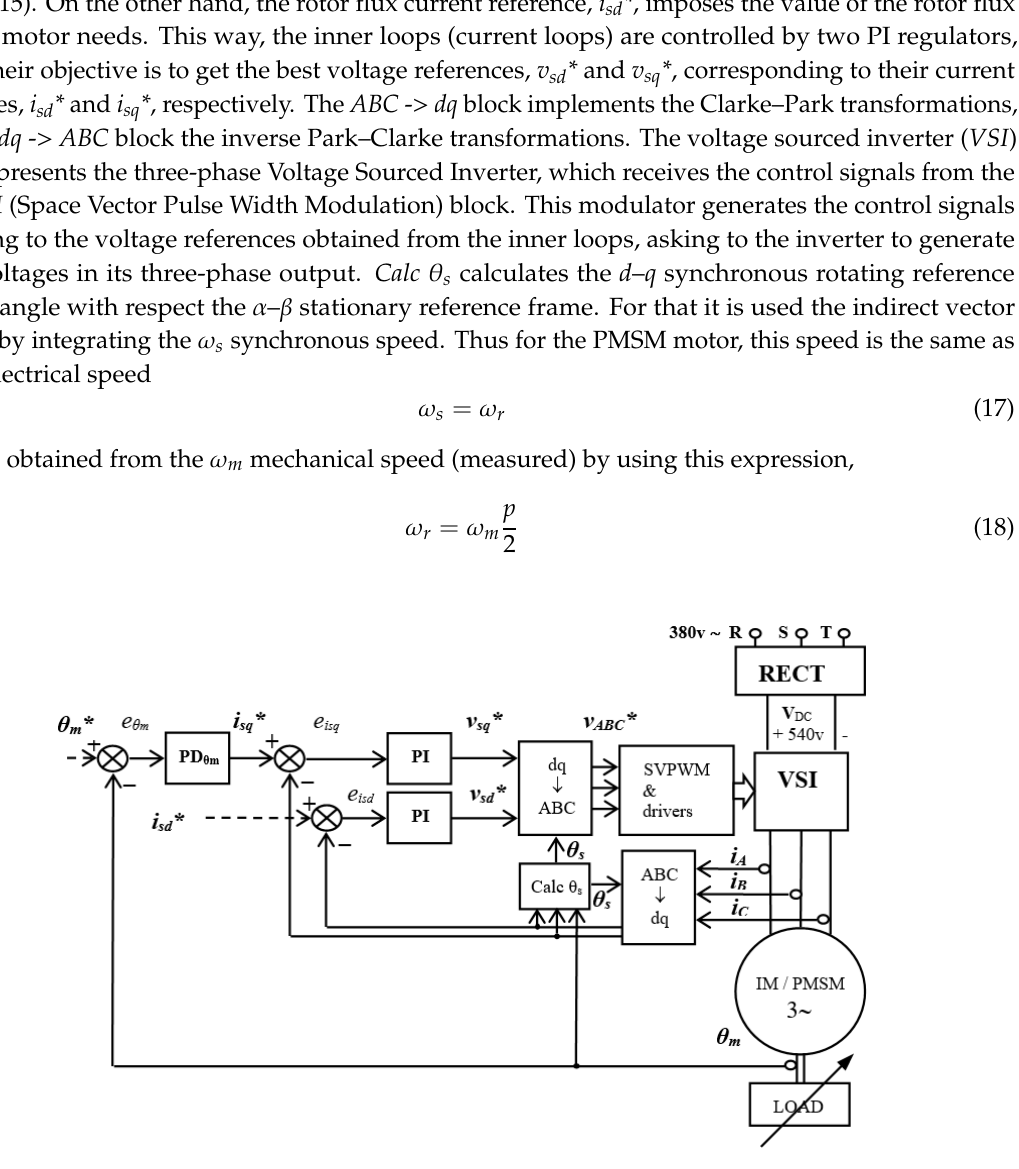
Figure 1. The proportional derivative position indirect vector control scheme for the three-phase motor.